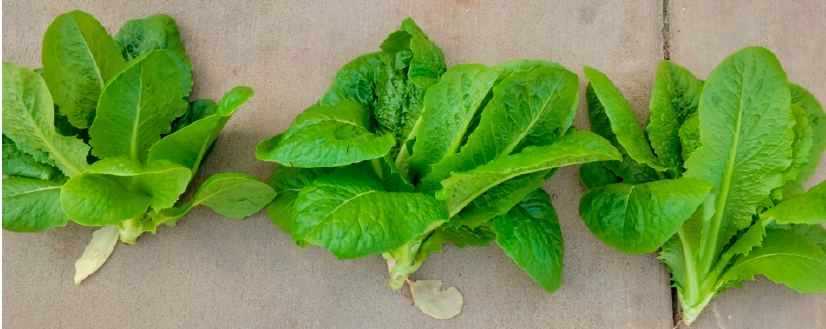
Figure 1. “Parris Island” grown at 18.3 °C (left), 21.1 °C (middle), and ambient (right).